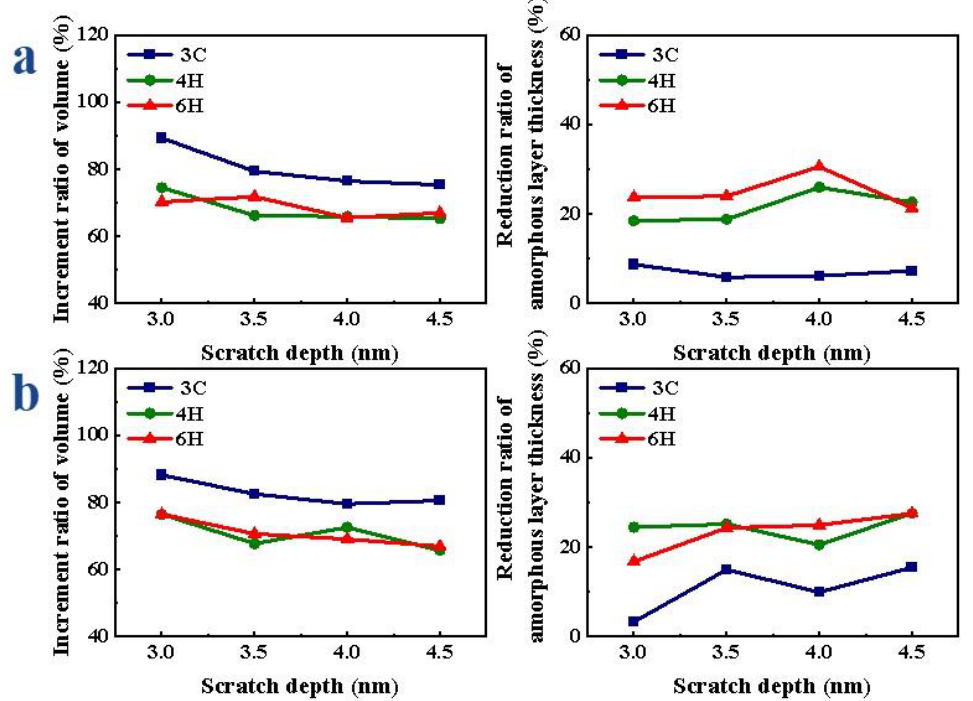
Figure 10. Amorphous atoms’ volume increment and amorphous atoms’ layer thickness reduction ratio of SiC polytypes with different depths: ( a ) Si-face and ( b ) C-face of SiC. After applying vibration, the V obviously increased and the thickness decreased at